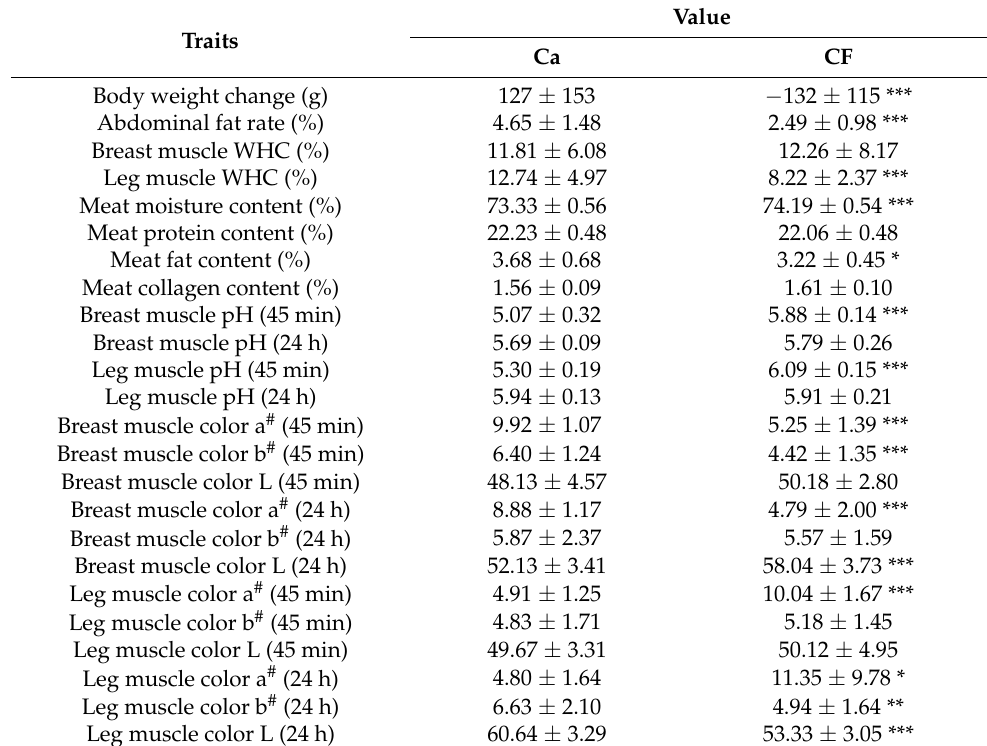
Table 1. Comparison of carcass and meat quality parameters between different rearing conditions.